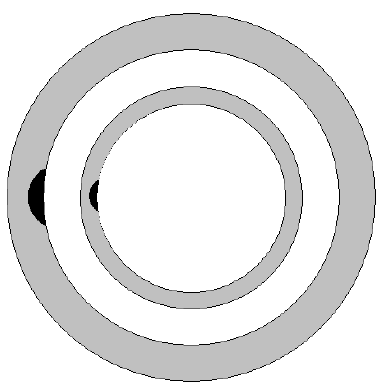
Figure 13: Stage-1 crack